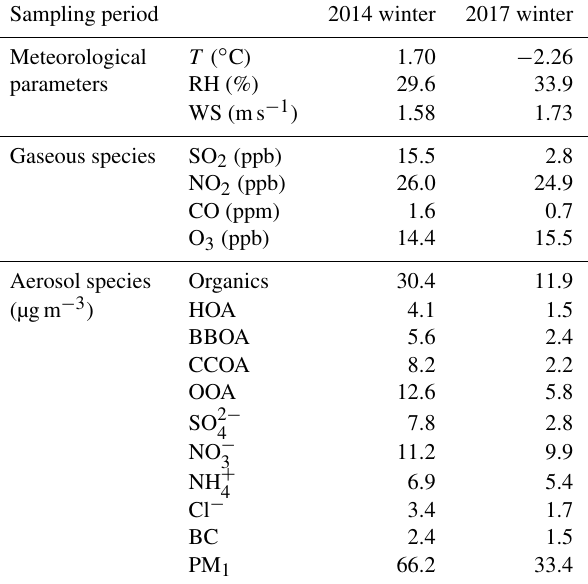
Table 1. Summary of the average meteorological parameters, mix- ing ratios of gaseous species, and mass concentrations of the PM 1 chemical components observed during the winters of 2014 and